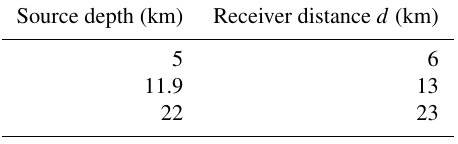
Table 1. Receiver distances used for different source depths accord- ing to results from Sect. 3.1.